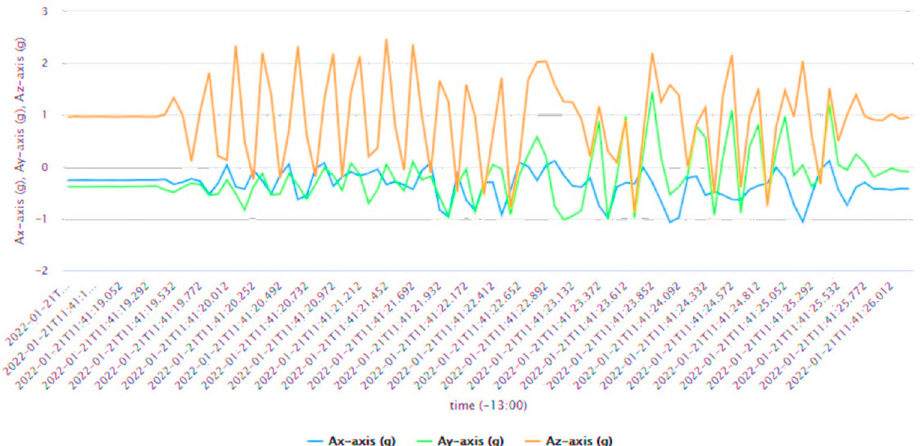
Figure 15. Variation in the acceleration data (in X, Y, and Z directions) during the different behavioral patterns associated with different ADLs performed at different time instants.